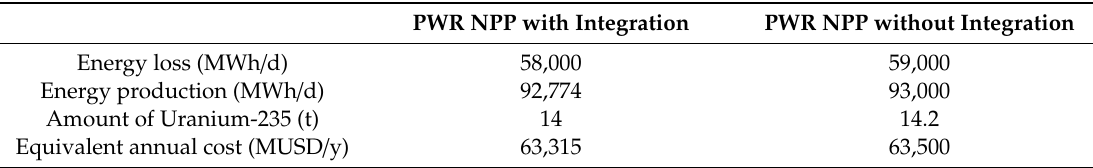
Figure 8. The final network of PWR NPP as a trigeneration without the integration of the Total Site. Table 11. Comparison of energy and costs between trigeneration PWR NPP with and without the integration of the total site